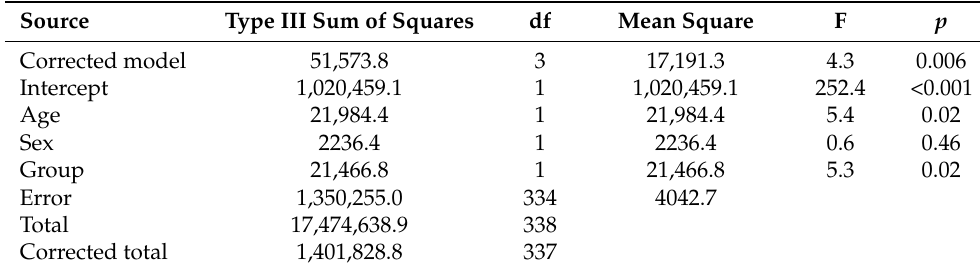
Table 2. MANCOVA analysis of TAS levels between ANFE patients and